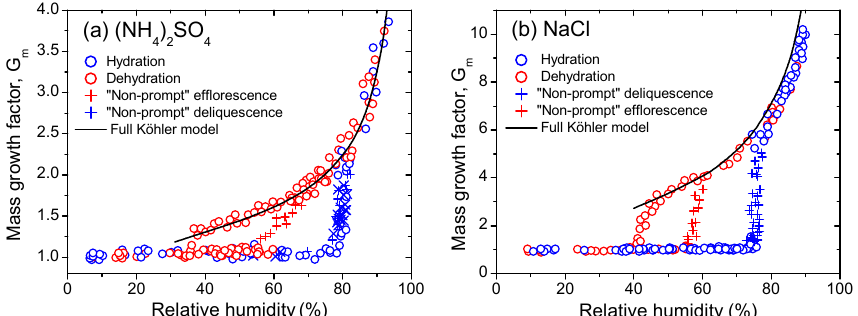
Figure 3. The mass growth factor ( G m ) of ammonium sulfate (a) and sodium chloride (b) aerosol particles observed as a function of relative humidity (RH) compared to the full Köhler model: blue and red crosses represent apparent non-prompt deliquescence and efflorescence thresholds.